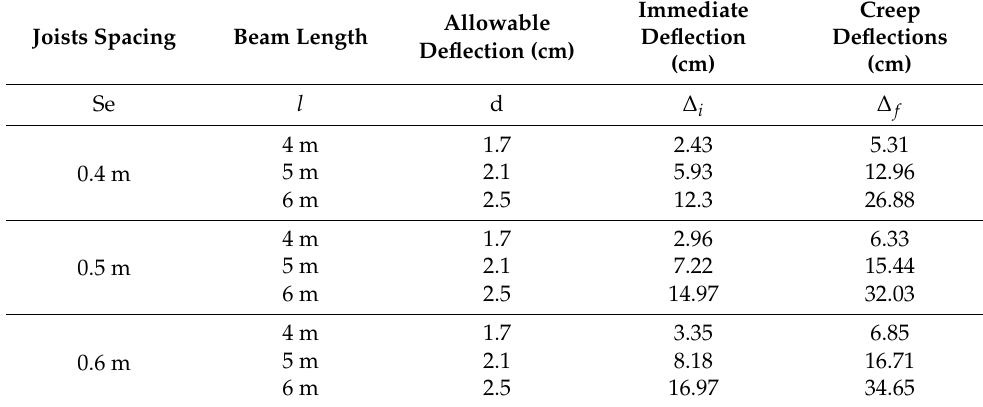
Table 6. Bending stress values.